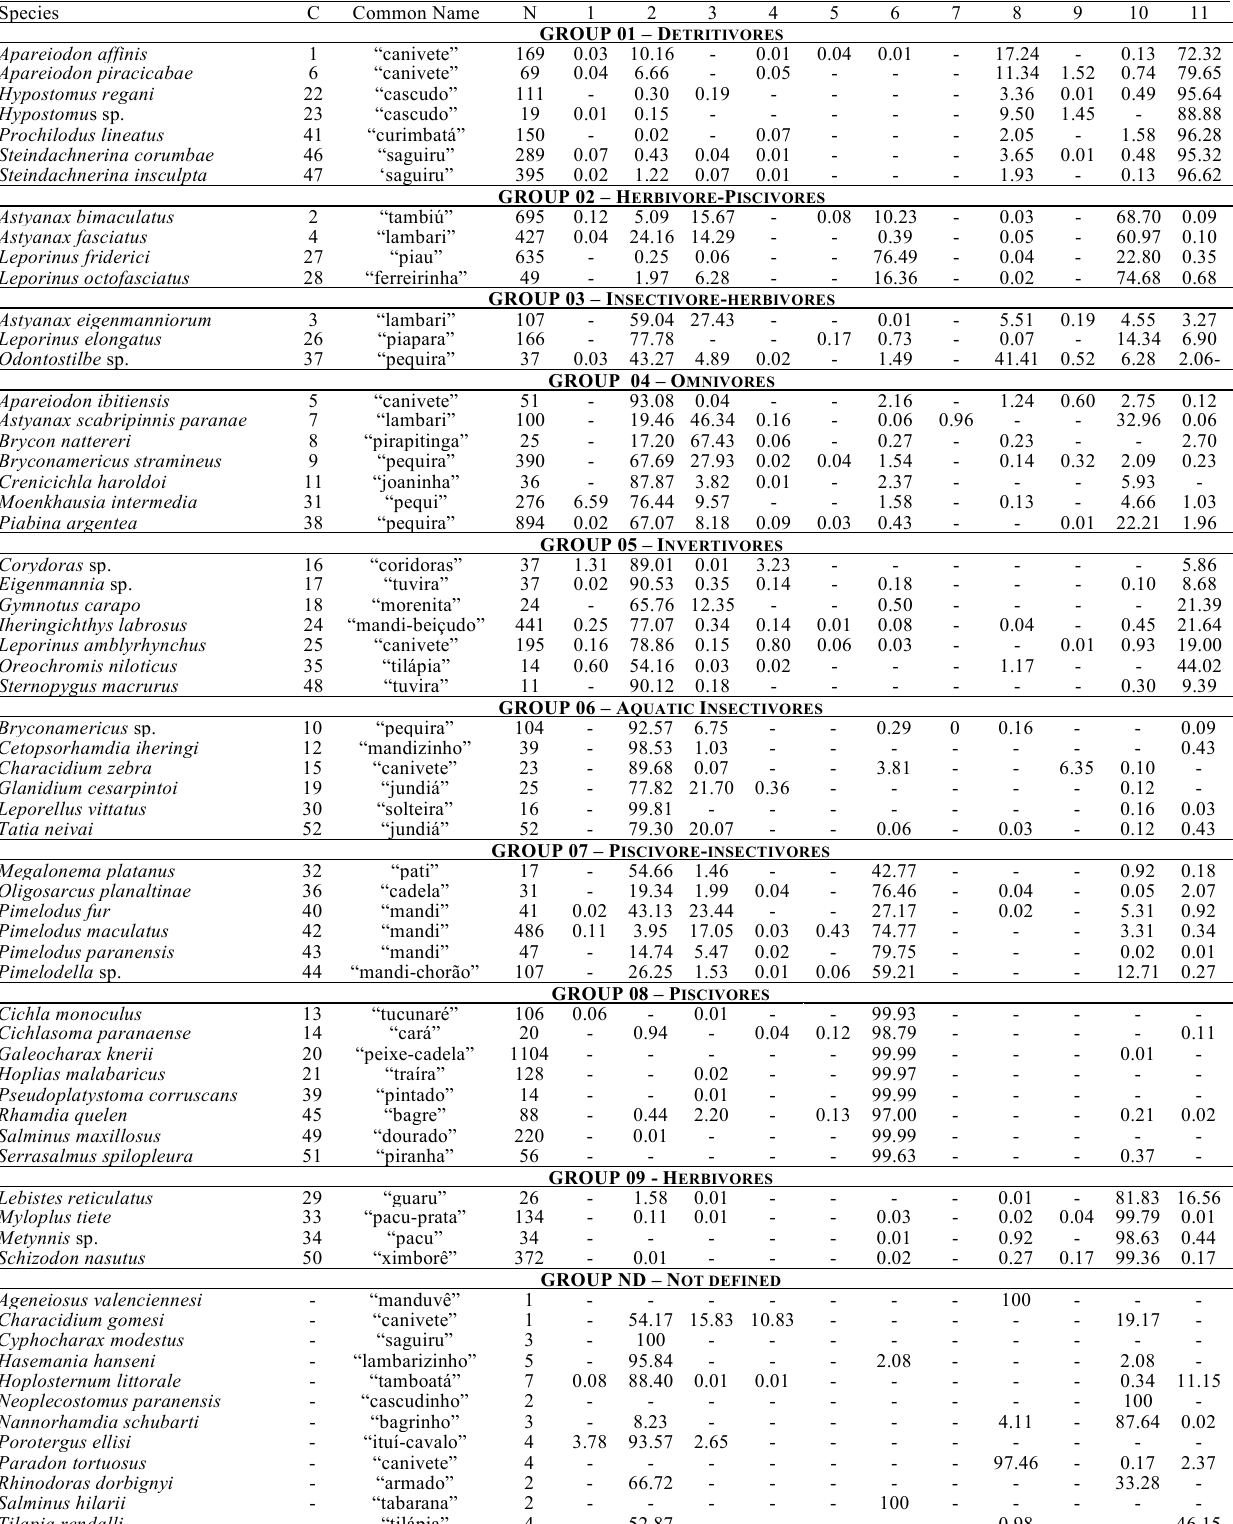
Table I . Main food resources (IAi %) consumed by fish species of the Corumbá river basin, combined for the entire sampling period and different biotopes (1=microcrustaceans; 2=aquatic insects; 3=terrestrial insects; 4=others aquatic invertebrates; 5=other terres- trial invertebrates; 6=fishes; 7=other vertebrates; 8=algae; 9=aquatic plants; 10=terrestrial plants; 11=detritus). C=species codes used at Figure 3; N=number of stomach contents analysed. See Trophic structure for characterization of the groups.